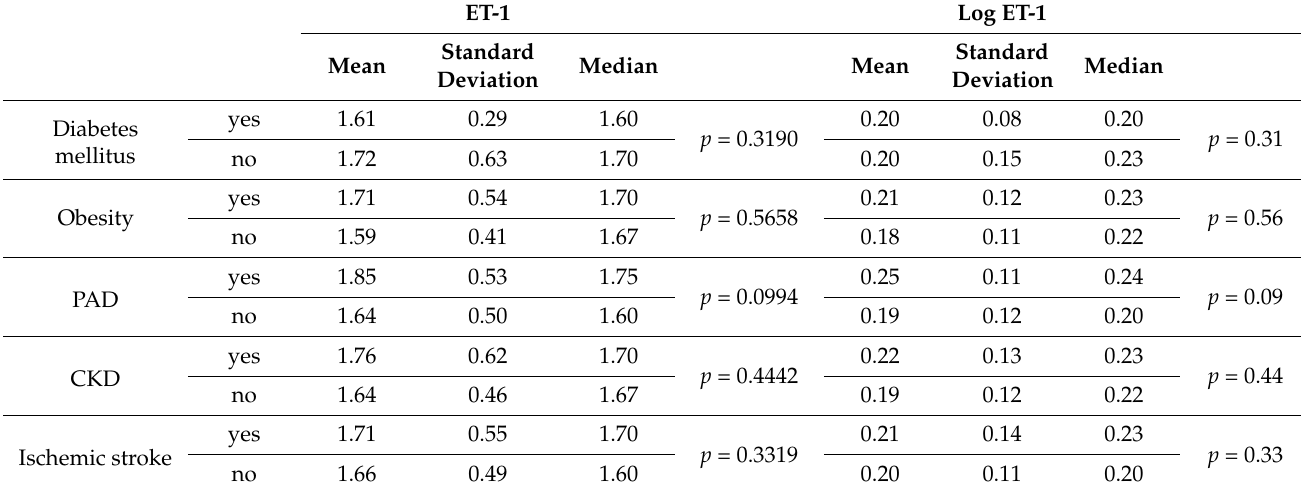
Table 7. The correlation between the serum levels of ET-1/Log ET-1 and the presence of associated comorbidities in the patients included in the